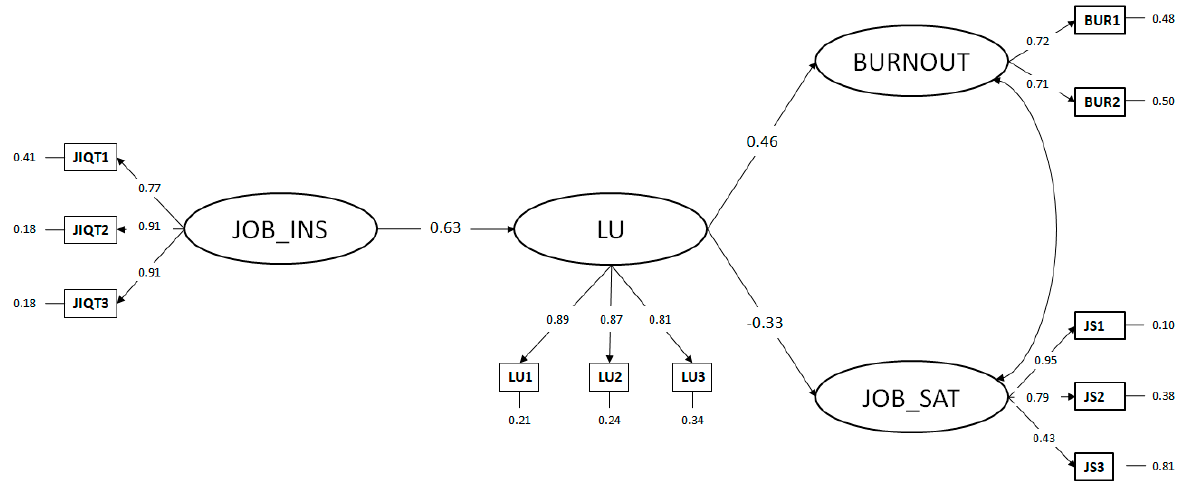
Figure 3. Mediation path analysis with latent variables. Note: Standardized coefficients were reported. All coefficients were statistically significant at p < 0.05. JOB_INS, job insecurity; LU, life uncertainty; JOB_SAT, job satisfaction. Fit Indexes: Chi-square (40) = 152.01, p < 0.01, CFI = 0.95, TLI = 0.93, RMSEA = 0.08, and SRMR = 0.07.